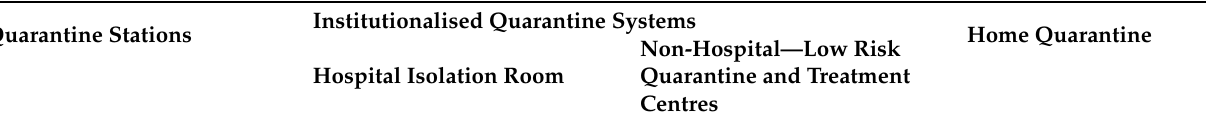
Table 2. Summary of Malaysia’s COVID-19 quarantine and isolation systems based on MOH